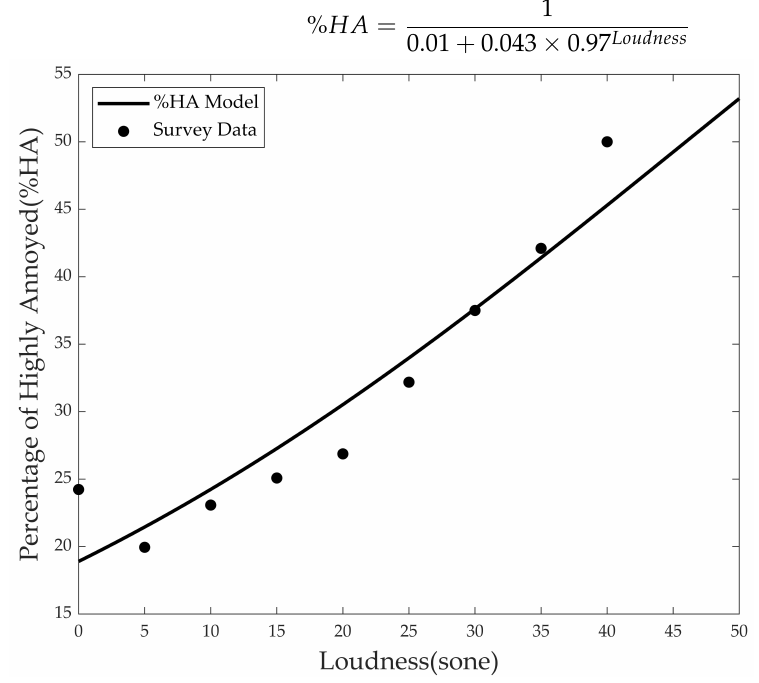
Figure 11. Long-term annoyance